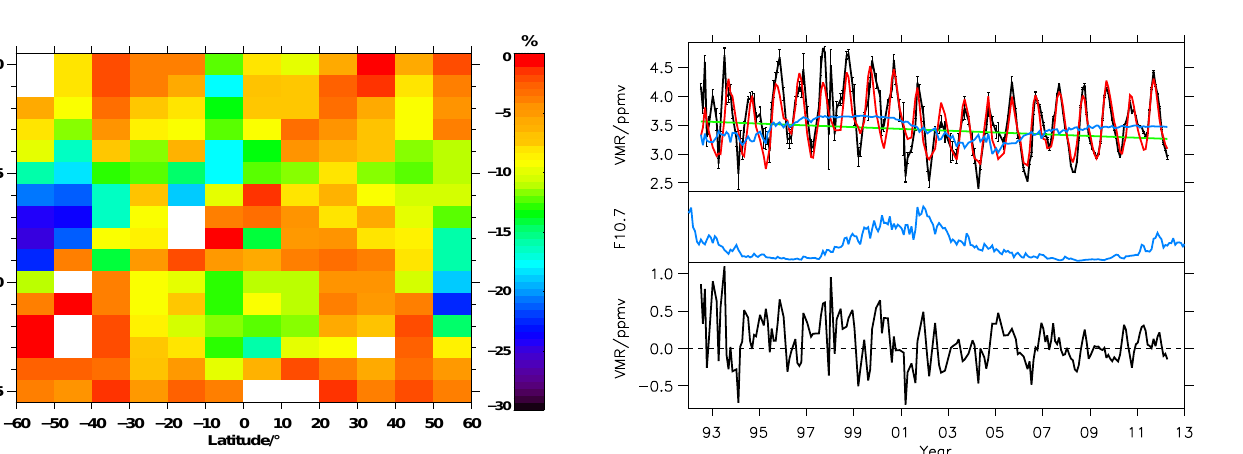
Figure 7. Top panel: fitted regression model with solar cycle ap- proximated by the F10.7 proxy as described under Approach 2 in Sect. 4.2. The blue curve is the fitted solar signal contribution with the F10.7 proxy. The middle panel (blue curve) shows the origi- nal solar cycle F10.7 parametrization in arbitrary units. In the lower panel the residual time series between the measured data and the fitted regression model is shown. The rms for this fit is 0.31ppmv. For further details, see Fig. 3.